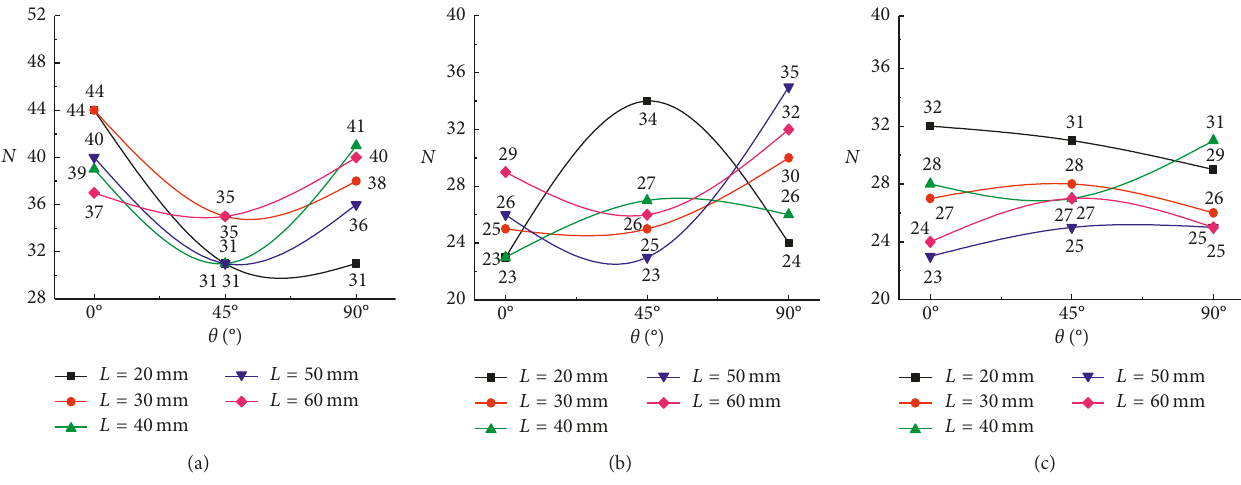
Figure 6: Relationship between θ and N . (a) Air; (b) soil; (c)